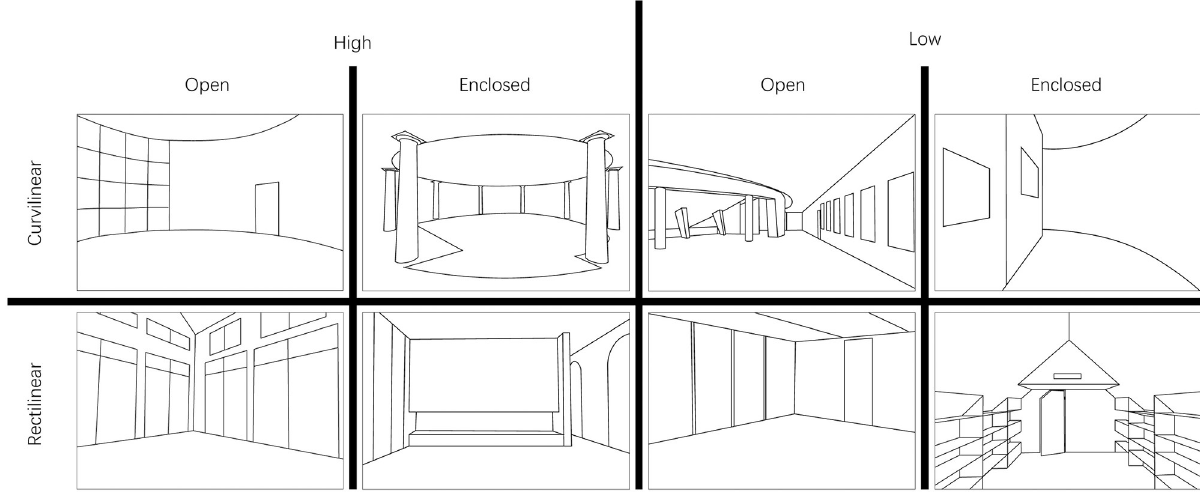
Fig 1. Examples of stimuli. A total of 200 pictures were divided into 8 conditions of 25 pictures each. The experiments used real photos and the line drawings are shown for illustrative purposes.